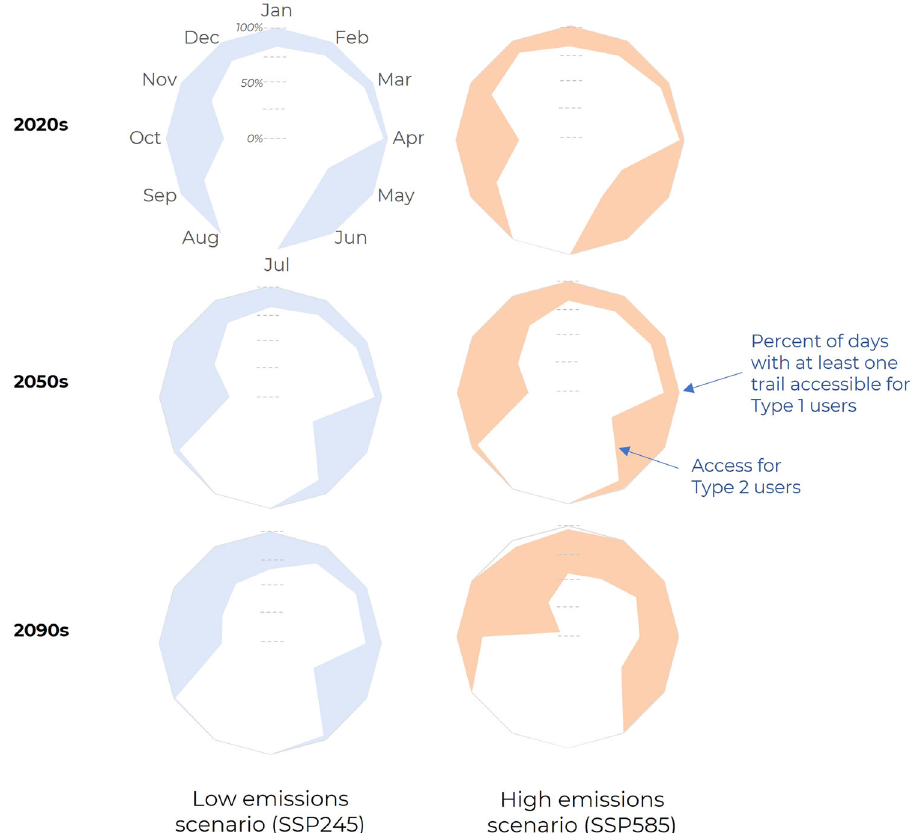
Fig. 6 Monthly percentage of good days for Type 1 and Type 2 users for select decades under a high and a low emission scenario. There is potential for adaptation to improve trail access under high and low emissions scenarios by giving Type 2 users (low-risk tolerance) the competence and con fi dence of Type 1 users